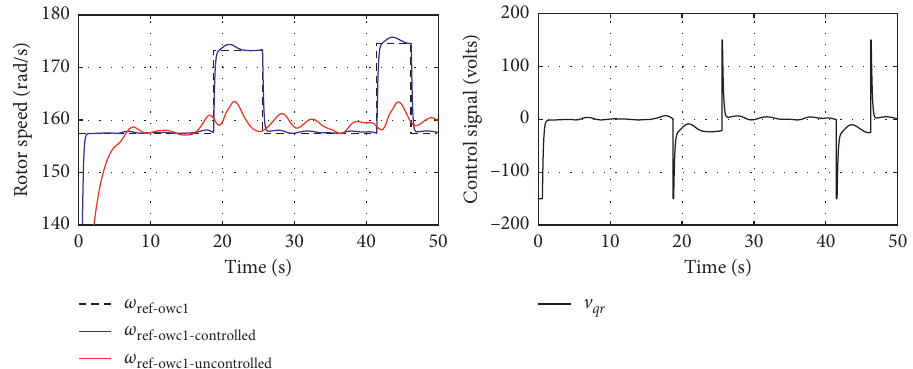
Figure 10: Rotor speed and control signal for OWC-1 with SW 1.